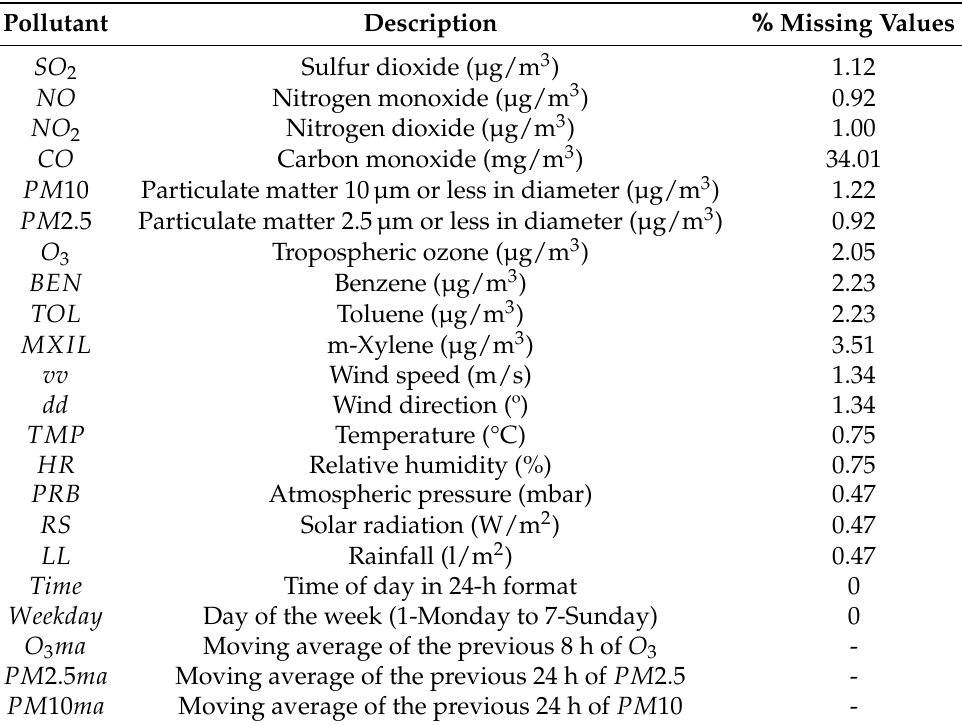
Table 2. Description of the predictive variables and their percentage of missing values in the original dataset.